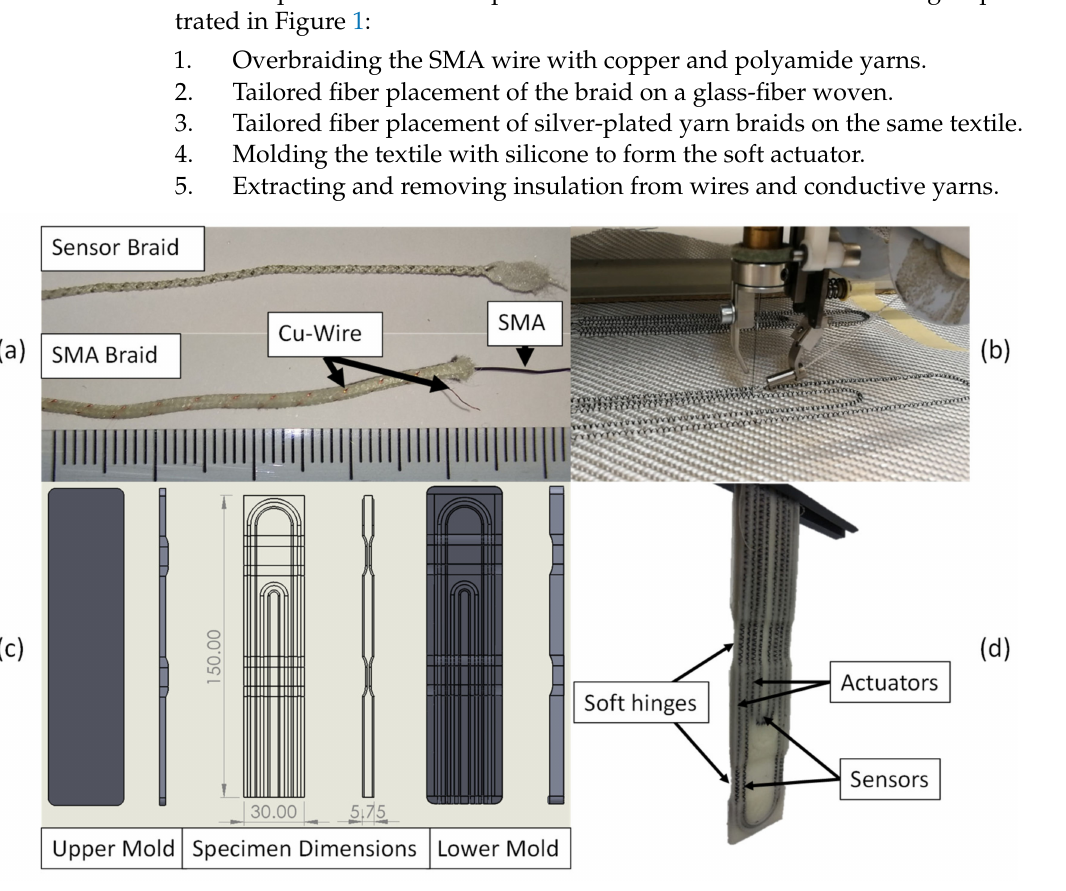
Figure 1. Manufacturing process of the soft actuator from ( a ) a braided Ni-Ti SMA core-sheath structure with copper wire and sensor braid; ( b ) tailored fiber placement of the braids to apply them to the glass fiber reinforcement textile; ( c ) molds and dimensions of the specimen; and ( d ) manufactured specimen with two soft hinges, two actuator and two sensor